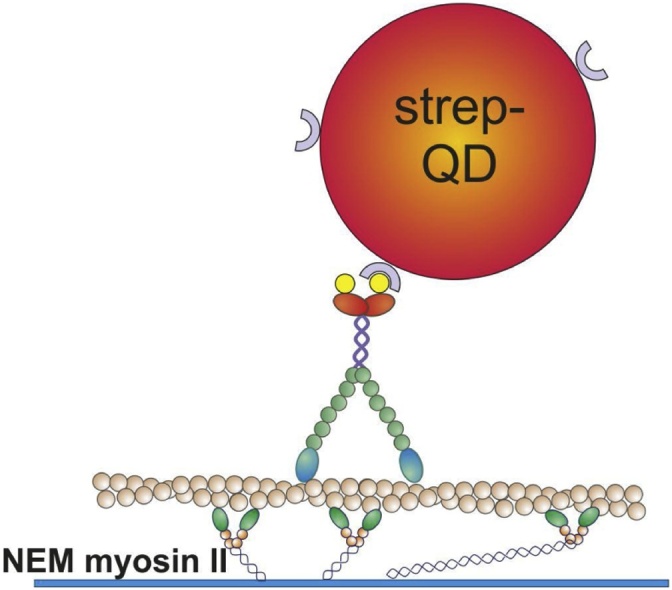
Sketch of the single molecule motility assay. Fluorescently-labelled actin filaments are attached on the nitrocellulose-coated coverslip surface through a layer of inactivated NEM-myosin II. Single biotinylated myosin-5B molecules attached to a streptavidinated QD walk along actin in the presence of ATP.